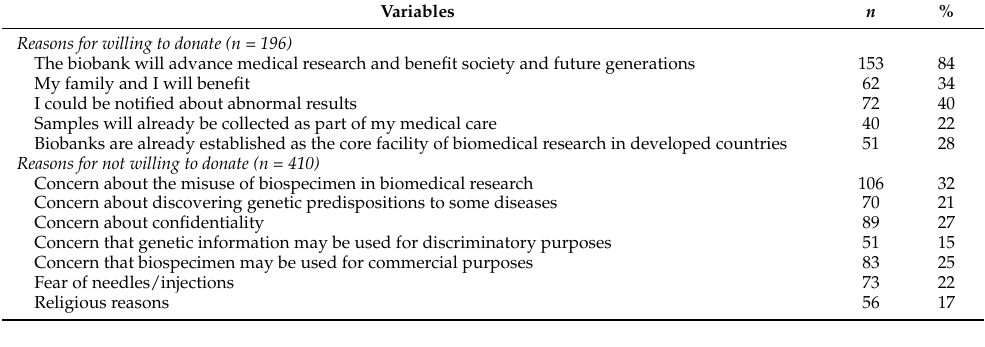
Table 6. Reasons for willingness or unwillingness to donate.